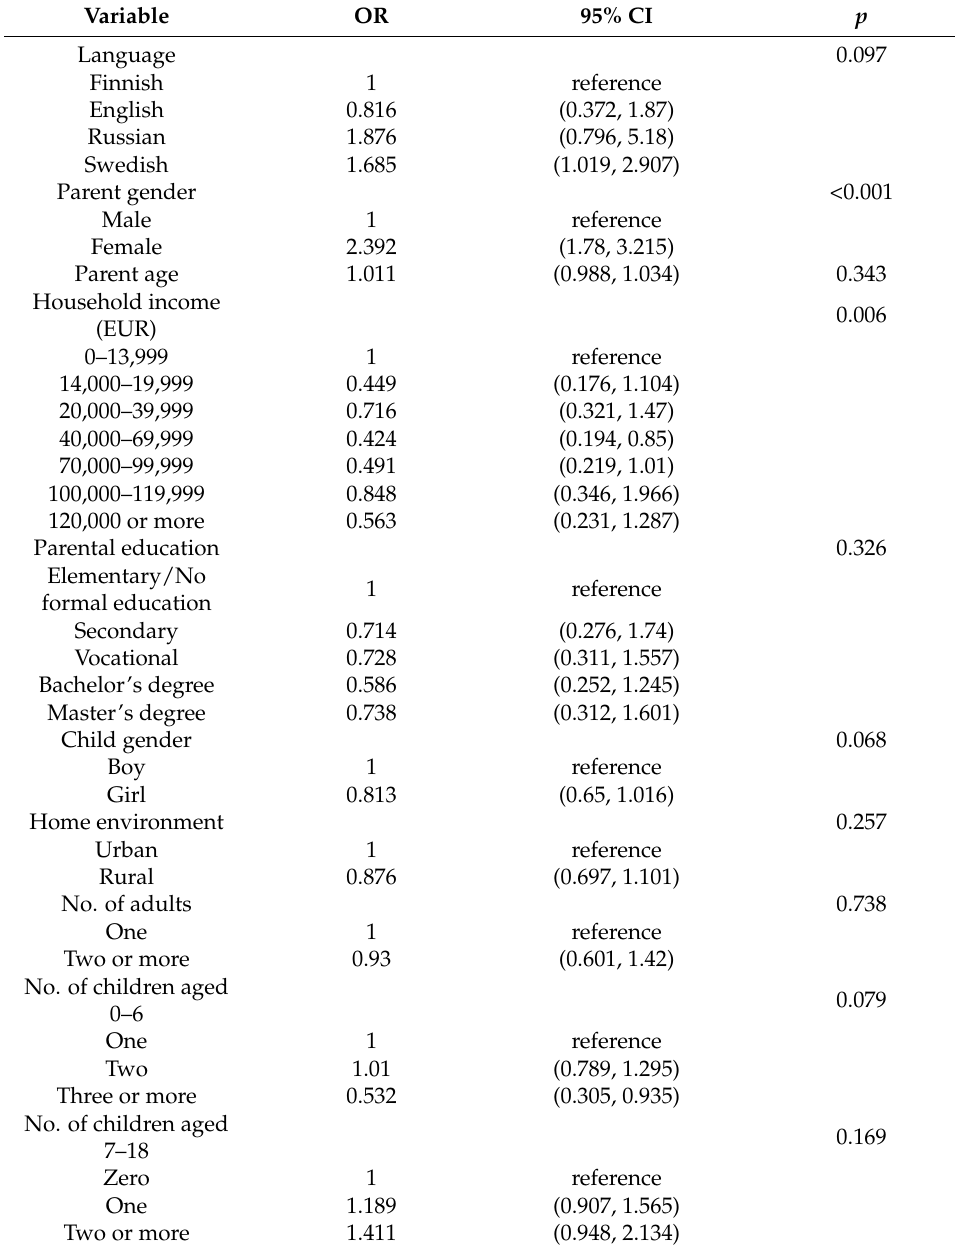
Table 6. Odds ratios (ORs) of sociodemographic variables to parental awareness of the guidelines regarding co-participation in child’s digital media use.